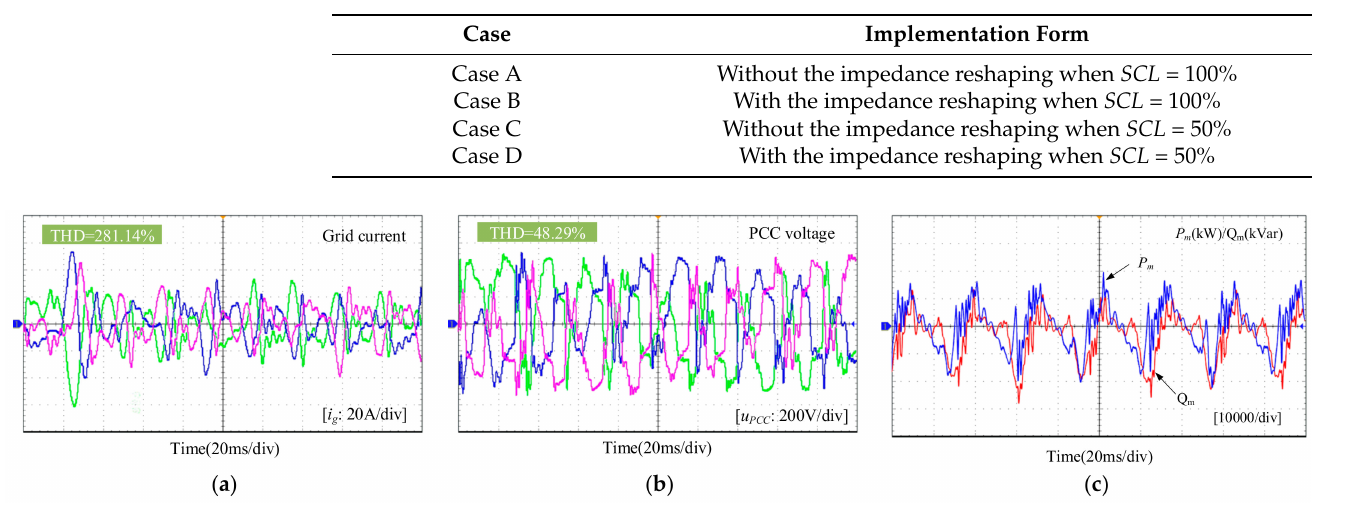
Table 2. Four cases under different control methods.